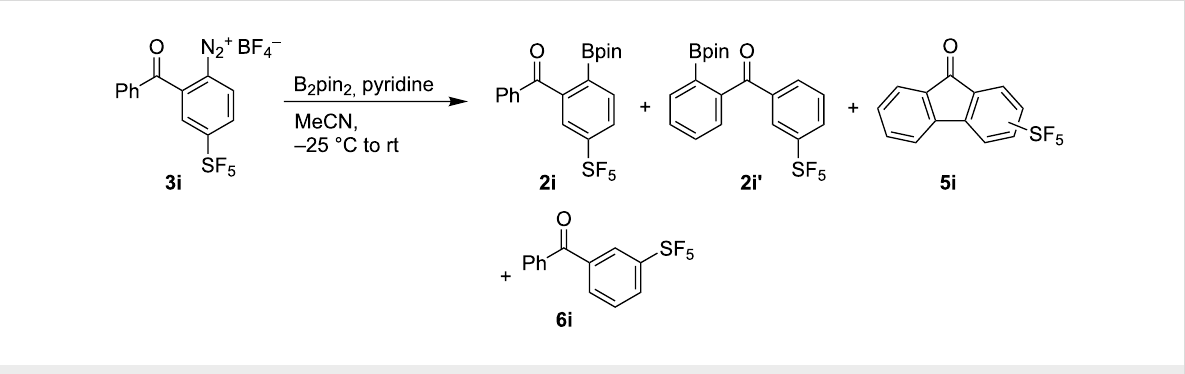
Scheme 3: Reaction of diazonium salt 3i under borylation conditions.